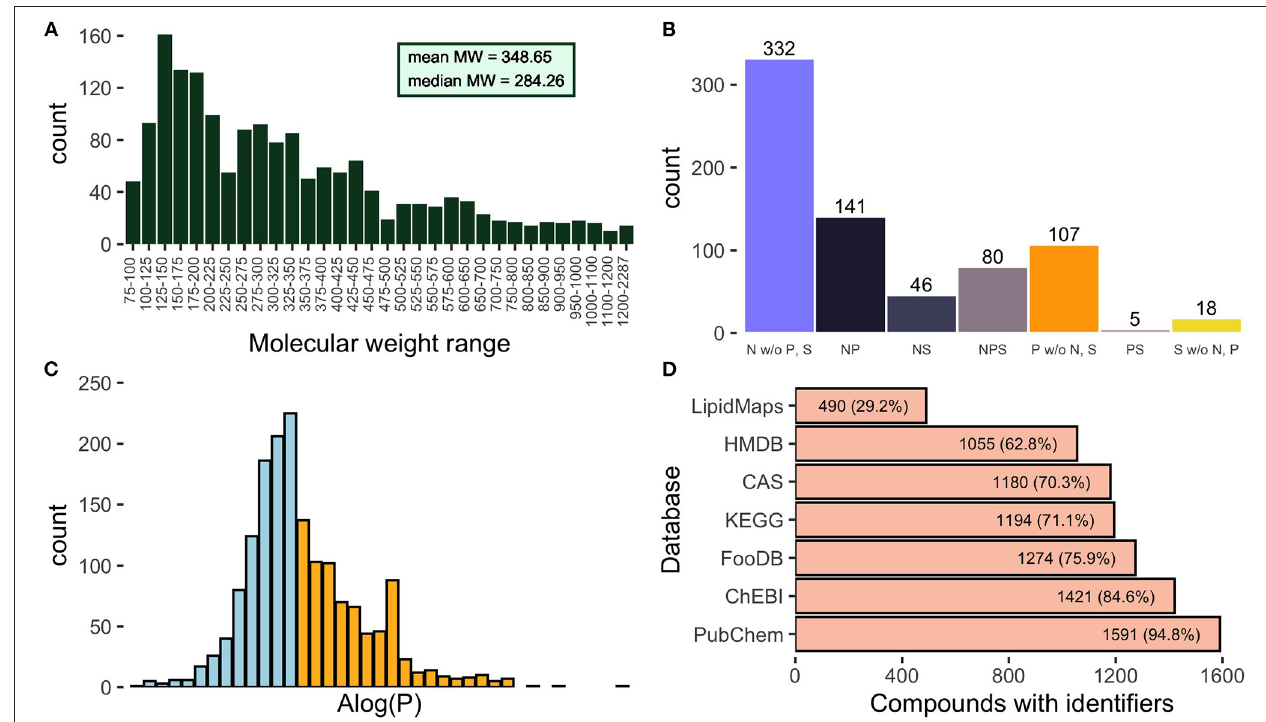
FIGURE 1 | General characteristics of 1,679 naturally occurring compounds in Citrullus lanatus . (A) Distribution of molecular weights of compounds comprising the catalog. Bins from 75 to 600 are sized by 25 units, from 600 to 1,000 by 50 units, and from 1,000 to 1,200 by 100 units. (B) Distribution of watermelon compounds containing atoms of nitrogen (N), phosphorus (P), and/or sulfur (S). The text “w/o” indicates without, e.g., compounds without phosphorus and sulfur in the leftmost column of the plot. (C) Distribution of watermelon natural products at different levels of calculated hydrophilicity and lipophilicity. Molecules were counted in bins of one unit of AlogP. Those predicted to be hydrophilic are plotted in light blue with the strongest predicted hydrophilicity at the extreme left of the plot. Lipophilic compounds are in orange with the most lipophilic entities at the far right of the plot. (D) Compounds with identifiers in standard chemical repositories. Two hundred ninety-eight compounds have identifiers in all seven of these